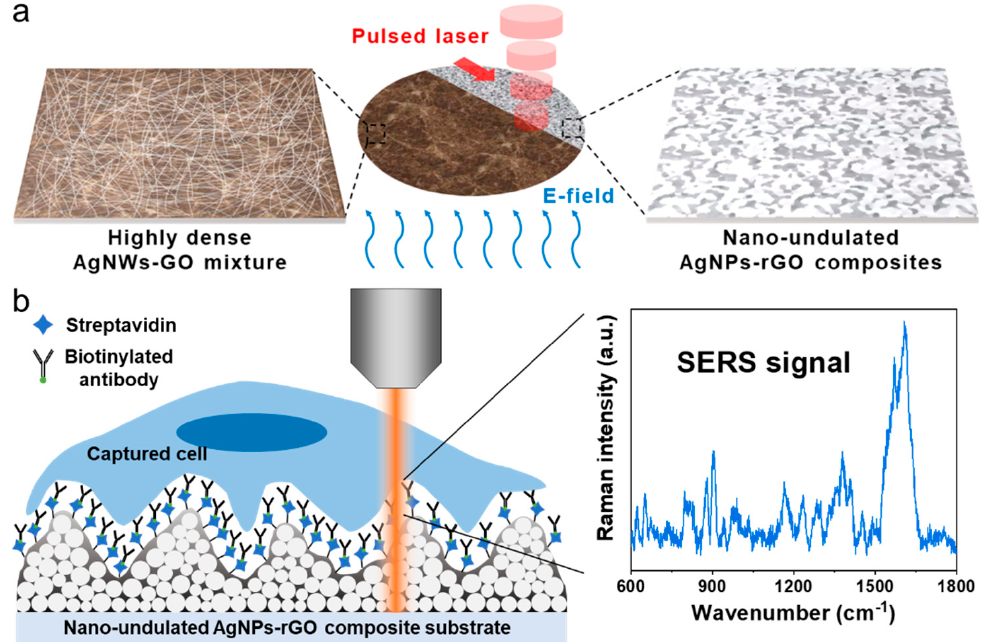
Figure 1. Schematic illustration. ( a ) The electric field-assisted pulsed laser reduction for the fabrication of the nano-undulated AgNPs-rGO composite substrate; ( b ) Capture and surface-enhanced Raman scattering (SERS) analysis of circulating tumor cells (CTCs). The highly soft nanostructure surface functionalized with an anti-EpCAM antibody improved the capture efficiency. Hot spots generated from the narrow nanogaps in the substrates greatly increased the SERS signals of the captured cells.